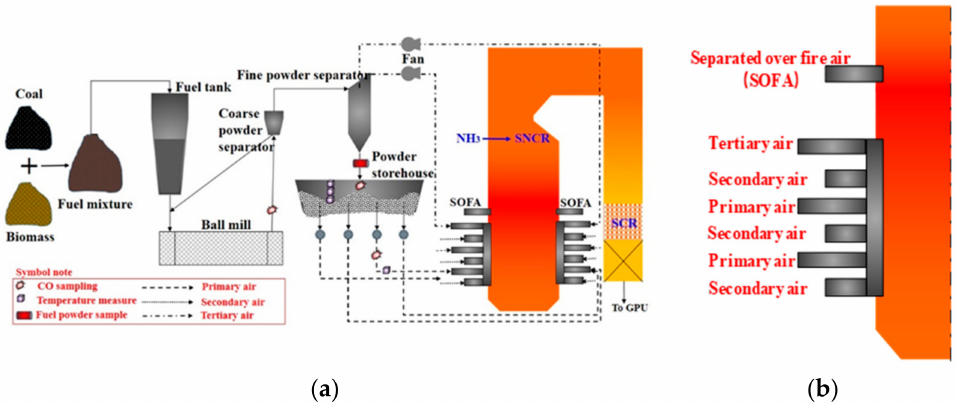
Figure 2. ( a ) Biomass co-firing system ( b ) burner port layout. Table 3. Proximate and ultimate analysis of fuel used in biomass co-firing test. Proximate Analysis Condition